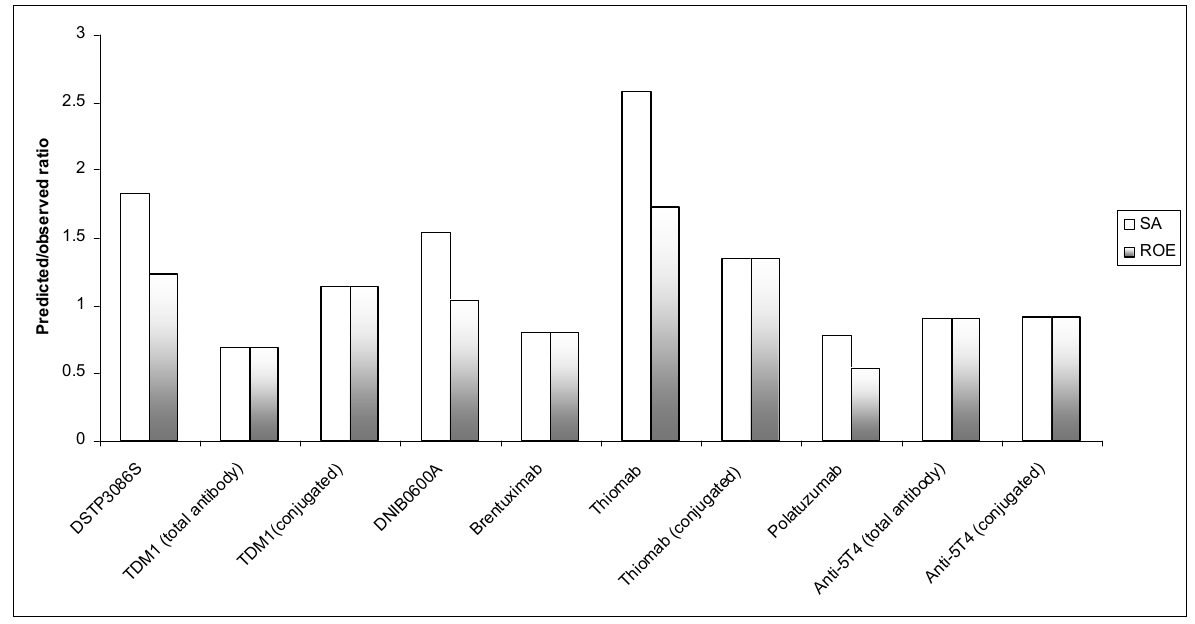
Figure 1. Predicted/observed ratio for the prediction of human clearance from three-species scaling using simple allometry (SA) and the “Rule of Exponent” (ROE). A predicted/observed ratio of 1 indicates no prediction error.